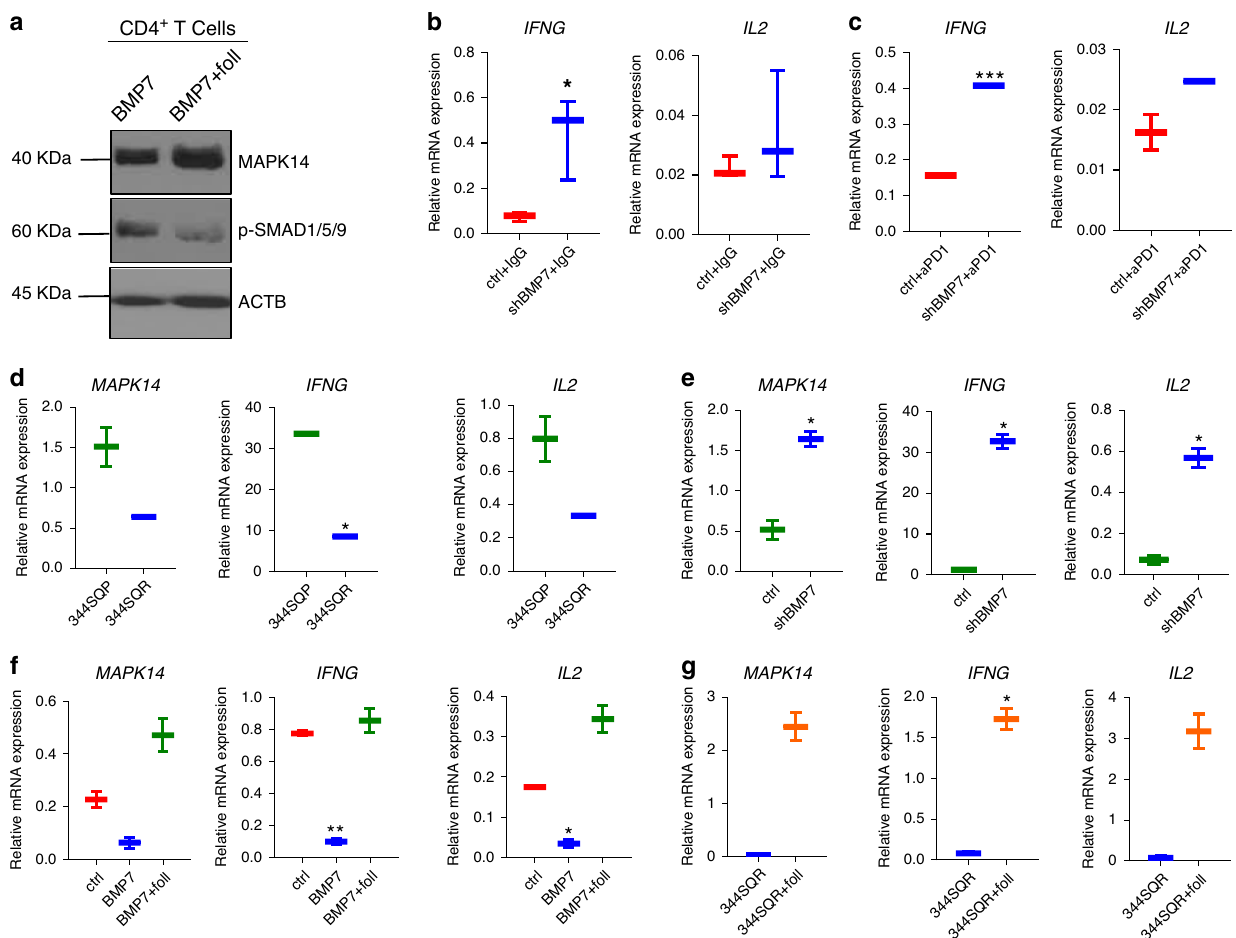
Fig. 4 BMP7 regulates CD4 + T-cell production of IFNG and IL2 via MAPK14. a Western blotting analysis of MAPK14 and SMAD1/5/9 phosphorylation in CD4 + T cells at 60 min after treatment with BMP7 (250 ng) or BMP7 plus follistatin (foll) (250 ng). ACTB expression was used for normalization in western blotting. b , c BMP7-knockdown and – control cells (0.5 × 10 6 ) were injected into 129 Sv/Ev mice and treated with IgG ( n = 3 biologically independent samples) anti-PD1 (10 mg/Kg) ( n = 2 biologically independent samples) twice a week for 2 weeks. A week after the fi nal IgG or anti-PD1 treatment, tumor-in fi ltrating leukocytes (TILs) were collected, and expression of IFNG , and IL2 were analyzed by quantitative PCR. Box-and-whisker plots show the minimum and maximum values. P values are from unpaired, two-sided t tests. Statistical signi fi cance was de fi ned as * P < 0.05, ** P < 0.01, *** P < 0.001, and **** P < 0.0001. d , e Quantitative PCR of MAPK14 , IFNG , and IL2 expression in CD4 + T cells co-cultured with 344SQP or 344SQR, and 344SQR shBMP7 or 344SQR ctrl cells for 24 h. Box-and-whisker plots show the minimum and maximum values of two independent experiments. f Quantitative PCR of MAPK14 , IFNG , and IL2 expression in CD4 + T cells untreated and treated with BMP7 (250 ng) or BMP7 plus follistatin (foll) (250 ng) for 24 h. Box- and-whisker plots show the minimum and maximum values of two independent experiments. g Quantitative of MAPK14 , IFNG , and IL2 expression in CD4 + T cells co-cultured with 344SQR cells or 344SQR cells plus follistatin (foll) (250 ng) for 24 h. Box-and-whisker plots show the minimum and maximum values of two independent experiments. CD45 expression was used as a housekeeping gene for quantitative PCR analysis. The comparative Ct method was used to calculate the relative abundance of mRNAs compared with CD45 expression. P values are from unpaired, two-sided t tests. Statistical signi fi cance was de fi ned as * P < 0.05, ** P < 0.01, *** P < 0.001, and **** P < the p value of BMP7 is close to signi fi cance in the multivariate model, we searched in The Gene Expression Omnibus (GEO) database for a second cohort of lung adenocarcinoma patients to have at least 100 patients. We found GSE50081 with 181 Stage I and II NSCLC cases from Der SD et al. 2014 30 . We retrieved microarray (Affymetrix Human Genome U133 Plus 2.0 Array) expression (normalized log2) data for BMP7 along with clinical information for the patients. Among them, 127 cases are adeno- carcinoma cancers. We performed univariate and multivariate Cox analysis and BMP7 (21160_at) was an independent marker of poor overall survival (Supplementary Table 5c – e, Supplementary Fig. 10a; Supplementary methods). We also analyzed the corre- lation between BMP7 expression and immune cells markers, model including BMP7 and Stage (Supplementary Table 5a, b). As including MAPK14, CD68 (resident-tissue macrophages maker),